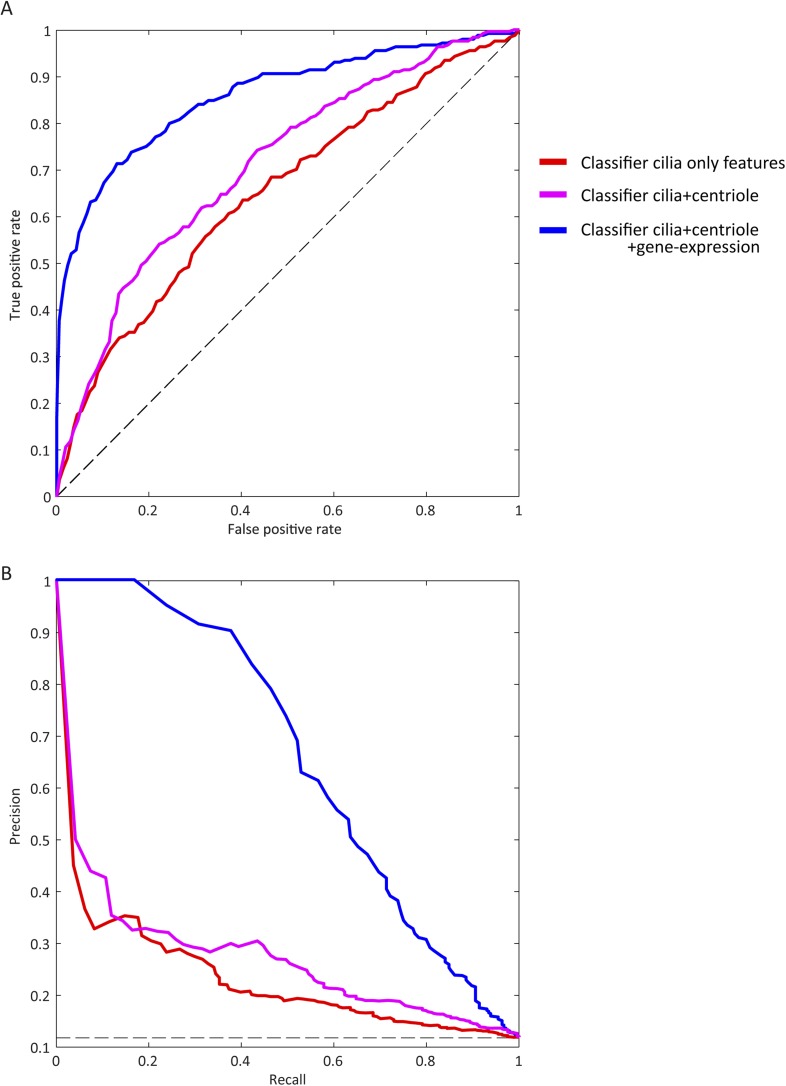
Visible improvement of ROC curve and precision-recall curve.(A) ROC for classifiers trained on different partitions of the feature space (blue: final set, magenta: excluding centriole biogenesis siRNA based features, red: including only features from the whole genome siRNA screen performed in this study). The dashed black line corresponds to a theoretical random classifier. (B) As in A but showing precision-recall curve for each classifier.